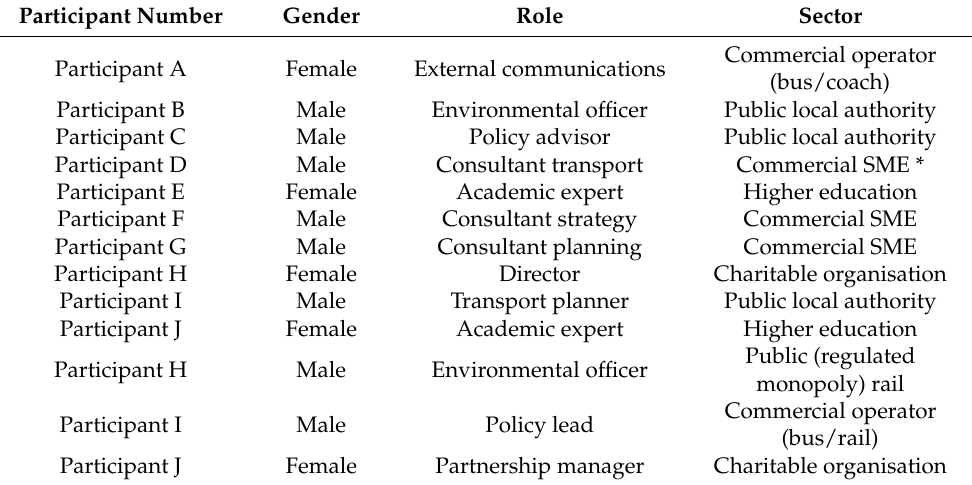
Table 3. Characteristics of the PSM workshop